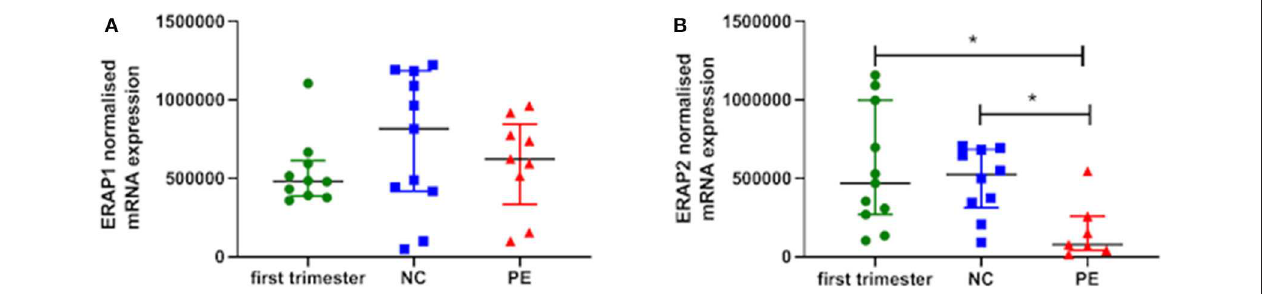
FIGURE 1 | Normalized mRNA expression (copy number) of (A) endoplasmic reticulum aminopeptidase (ERAP)1 and (B) ERAP2 in placentae from first trimester ( n = 12), term normotensive controls (NC; n = 12), and women with pre-eclampsia (PE; n = 12). Data are presented as median [interquartile range (IQR)]; * P < 0.05.